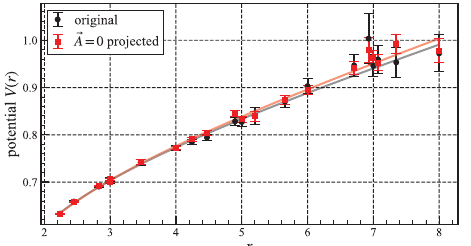
Figure 1. The static quark-antiquark potentials evaluated from the original configurations (black) and (cid:3) A = 0 projected ones in the Coulomb gauge (red). The black and red curves are the fit results with the Cornell potential V ( r ) = − A / r + σ r + const.